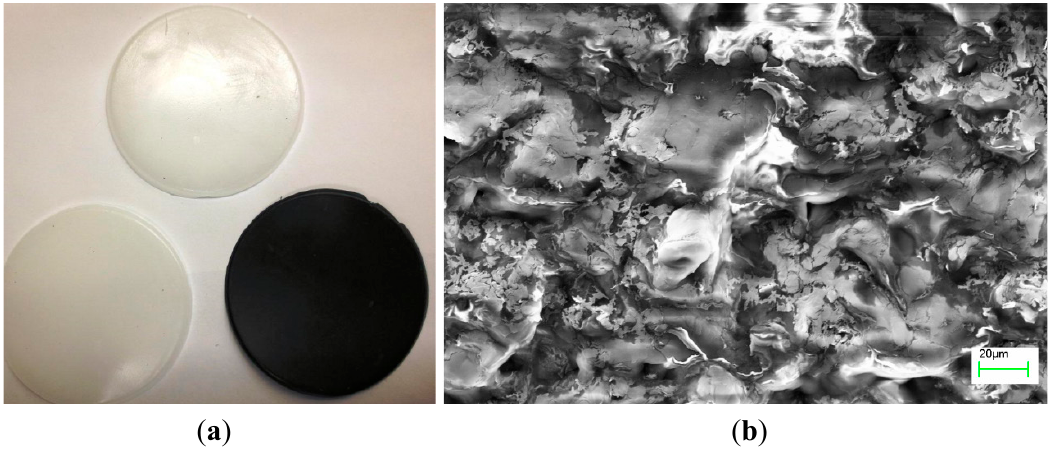
Figure 3. Hybrid graphene—paraffin phase change material. ( a ) Optical image of the PCM samples showing the change in color from white to black with increasing graphene content; ( b ) Scanning electron microscopy image of the hybrid graphene-PCM indicating uniform distribution of the graphene